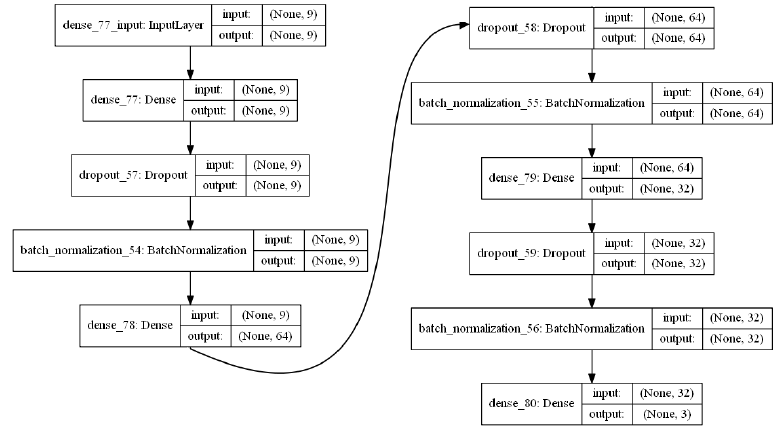
Figure 11: Architecture of the best trained